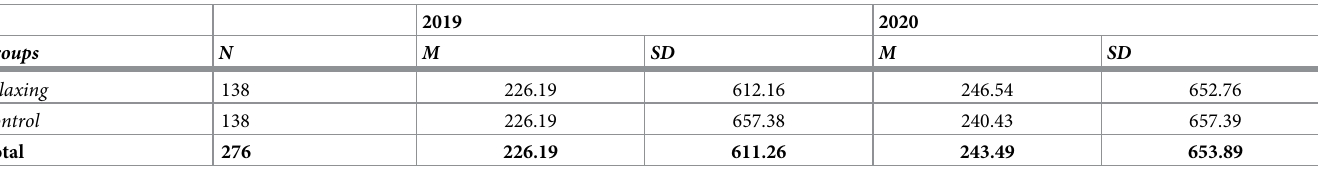
Table 3. Descriptive data of ADPPs by